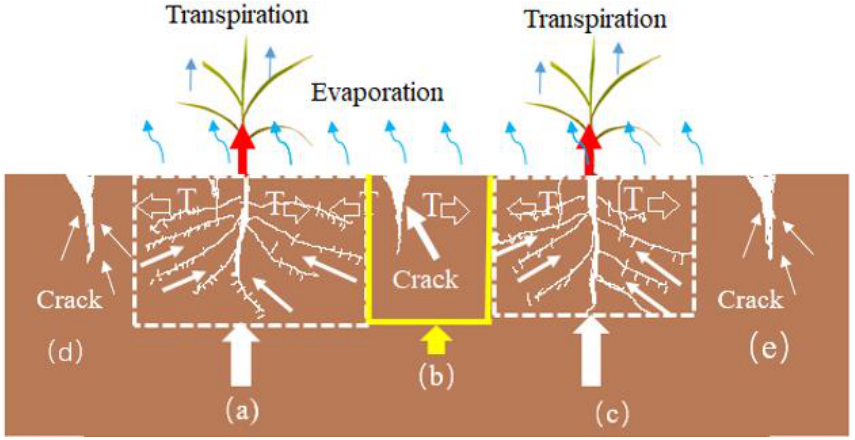
Figure 11. Mechanism of root soil crack.